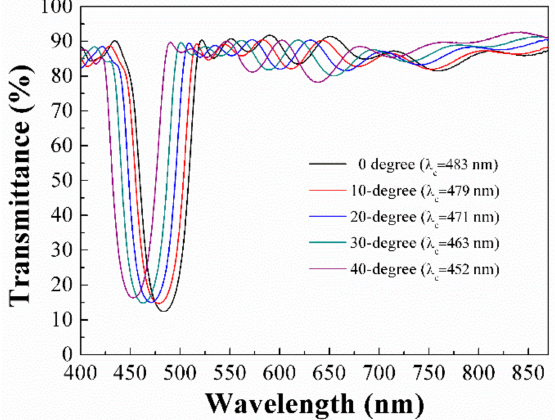
Figure 3. Transmittance spectra of the notch filter measured by different incidence